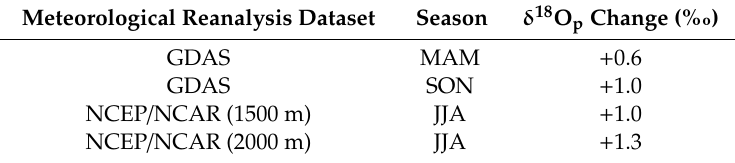
Table 2. E ff ect of a 20% less westerly-derived precipitation on δ 18 O p based on regression coe ffi cients between δ 18 O e p and dW if within a specific season they are statistically significant from Figure 5a. Results are compared with another study [28] in which the authors based on event-based precipitation samples concluded that precipitation derived from westerlies are on average 7% (cid:24) lower than easterlies and northerlies at R í o Gallegos and Laguna Potrok Aike (Figure 1). From a simple isotopic and mass balance calculation, it could be converted that a 20% less westerly-derived precipitation would have an e ff ect of + 1.4% (cid:24) in δ 18 O p for their sites. Meteorological Reanalysis Dataset Season